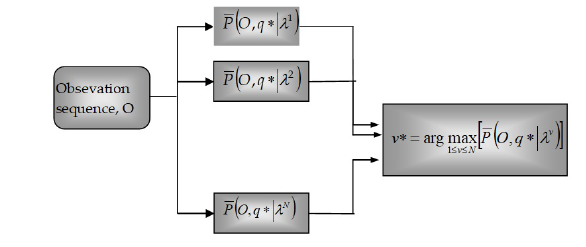
Figure 3: Learning user intention using HMM.